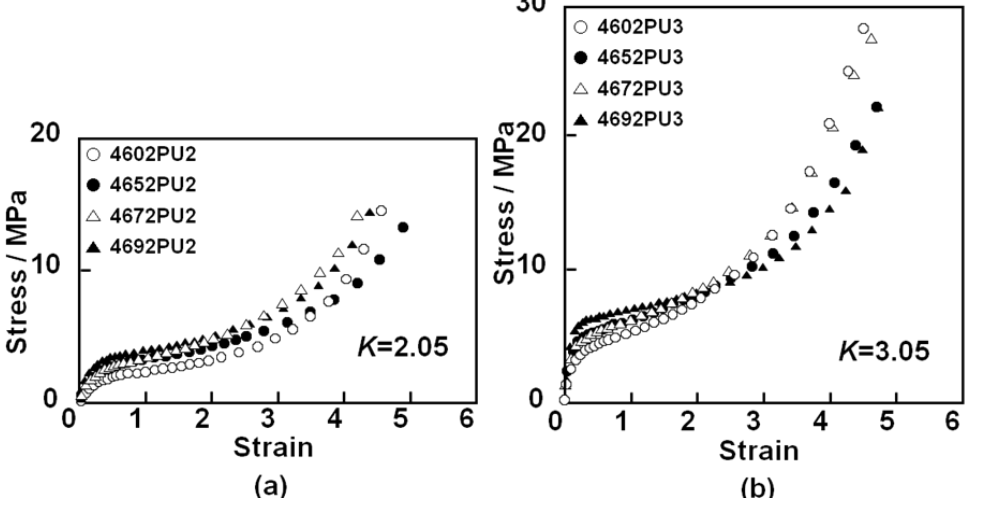
Figure 9. Stress-strain curves for PC-glycol-based PUEs. ( a ) K = 2.05 and ( b ) K =